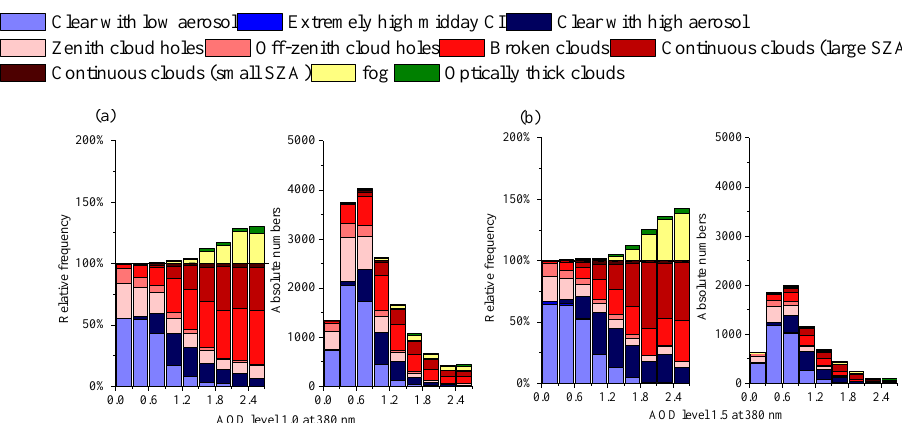
Figure 13. Results of the cloud classification scheme as a function of the AOD obtained from the AERONET measurements at Taihu. (a) The AODs are from the level 1.0 data sets without cloud-screening and (b) from automatically cloud-cleared level 1.5 data sets. In each subfigure, left: relative frequencies of the different sky conditions (see the caption of Fig. 10 and the text for details); right: absolute numbers of the sky conditions as a function of the